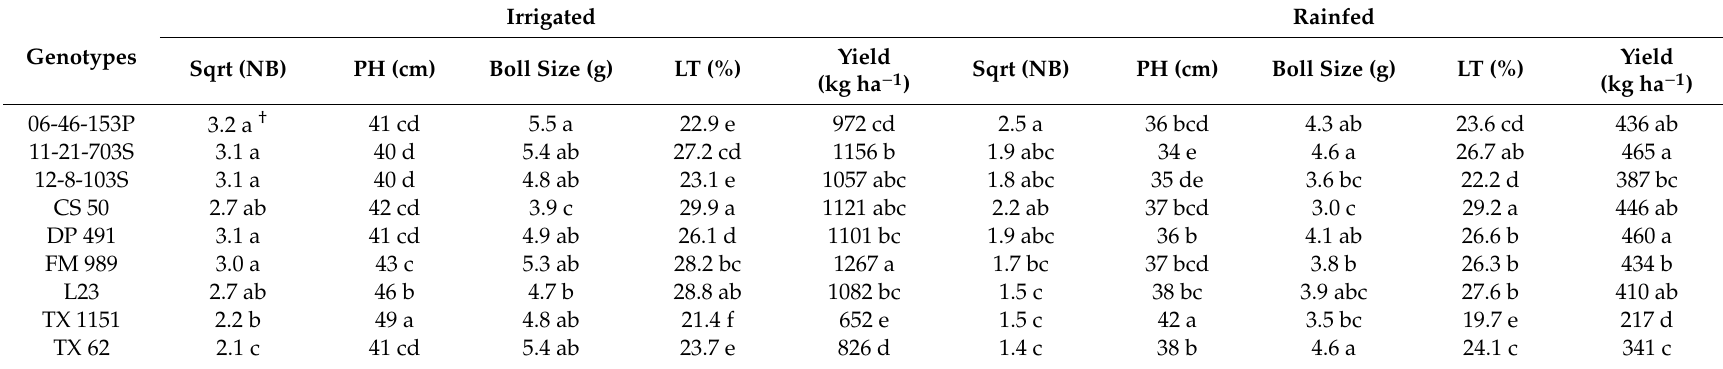
Table 2. Least square means for the number of bolls per plant (NB), boll size, plant height (PH), lint turnout (LT %), and lint yield of cotton lines grown under irrigated and rainfed